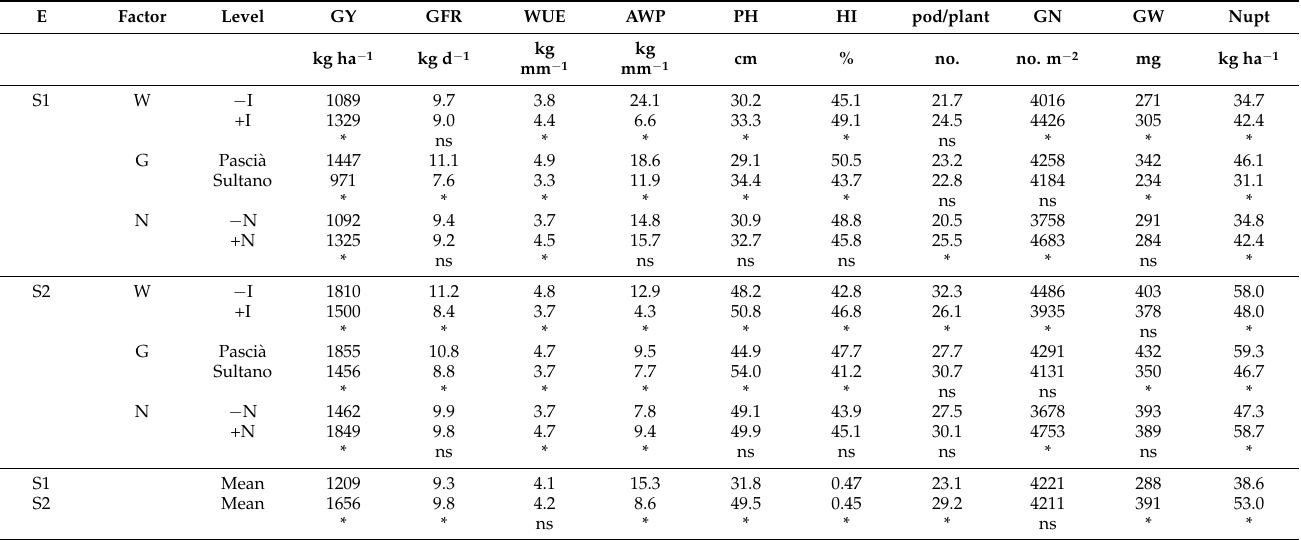
Table 5. Agronomic performance, in terms of yield, water use efficiency, and yield components of Pasci à and Sultano chickpea varieties grown under two water regimes and two N